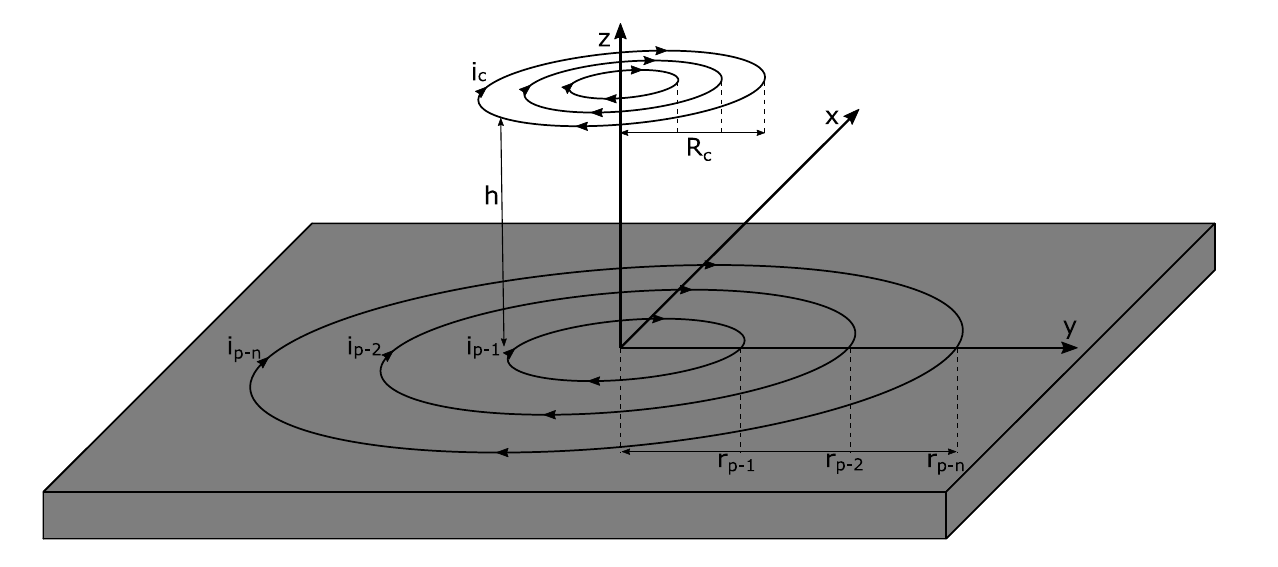
Figure 2. Circular current lines on the plate. Table 1. List of variables and their explanation used in the